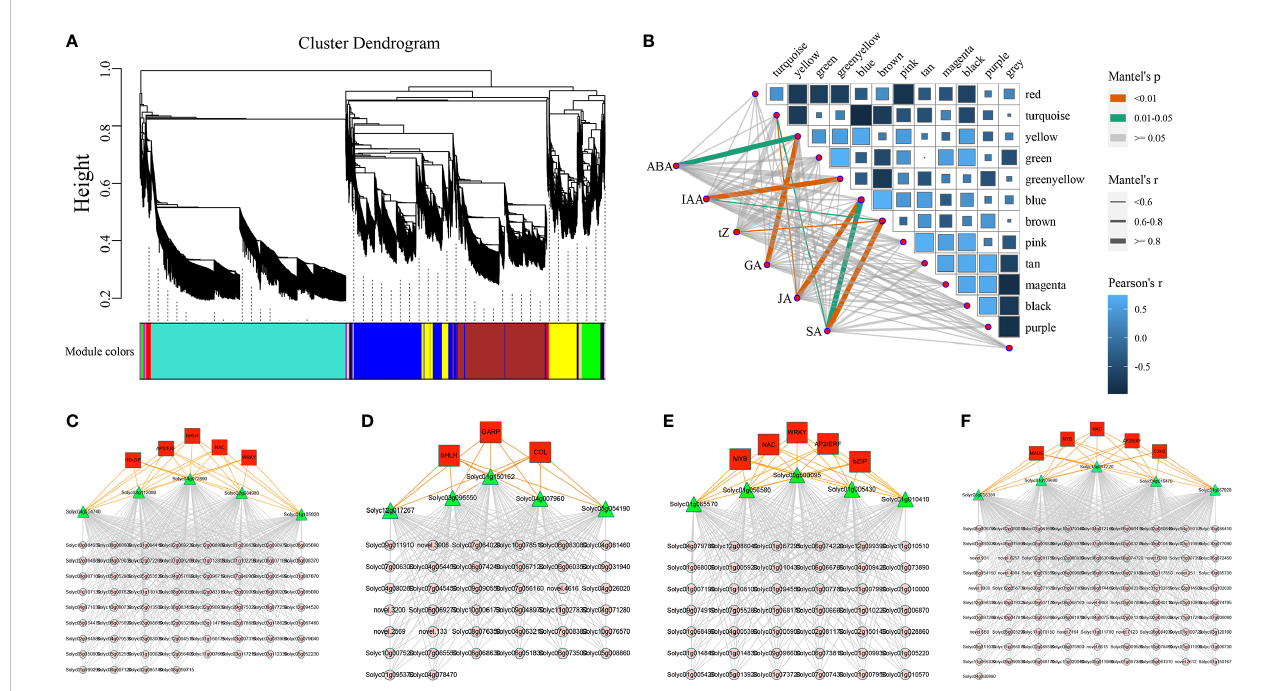
FIGURE 6 The correlations between different gene modules and hormones, co-expression networks, and the expression pro fi les of major transcription factors under salt stress. (A) The division of different gene modules (B) The heatmap illustrated the relationships between modules and hormones (C – F) The gene co-expression networks consisted of transcription factors, target genes, and hub genes for the yellow, green-yellow, blue, and brown modules.